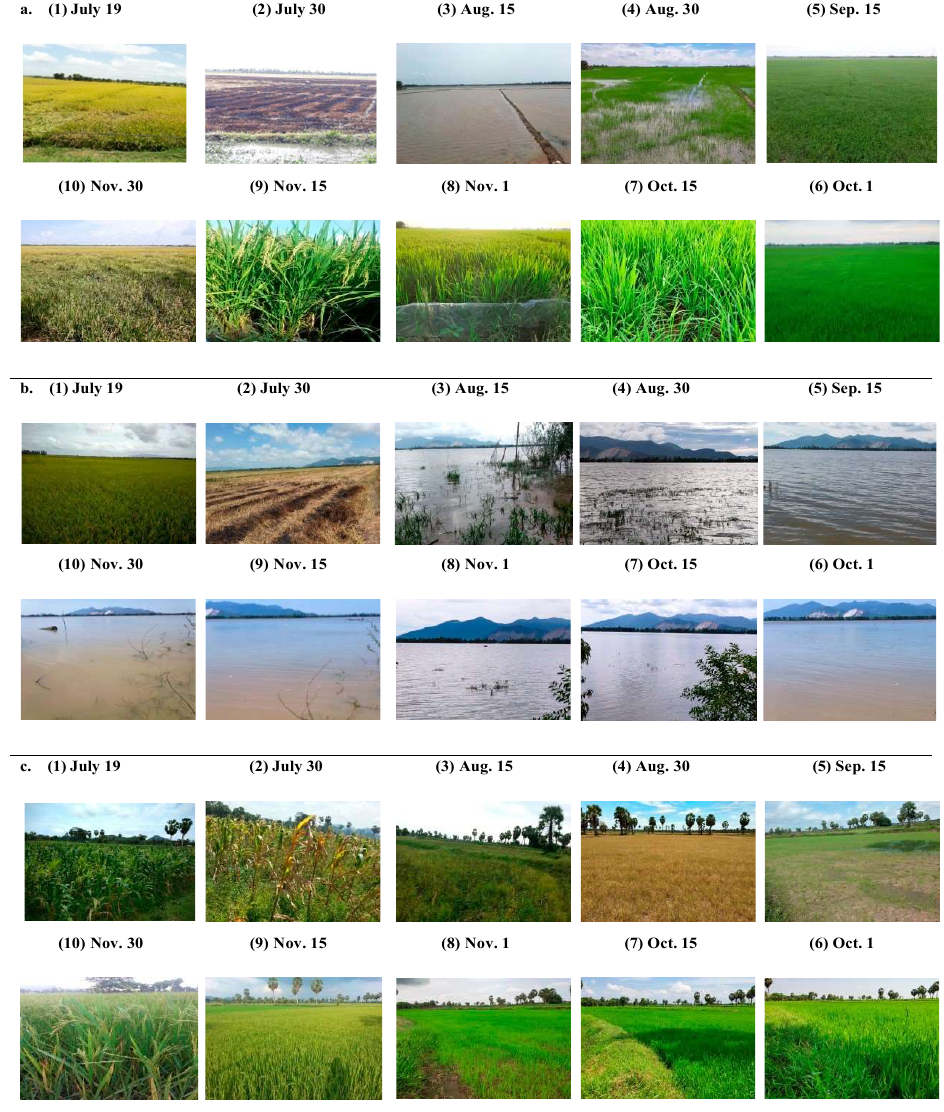
Figure 6. Rice growth stages for ( a ) triple-rice crop, ( b ) double-rice crop, and ( c ) single-rice crop. In the triple- and double-rice crops: ( 1 ) harvesting time and ( 2 ) soil preparation; 3 – 10 : summer–autumn season in the triple-rice system and fallow period in the double–rice system; in the single-rice crop: 1 – 4 show the vegetable season; 5 – 10 : autumn–winter season.